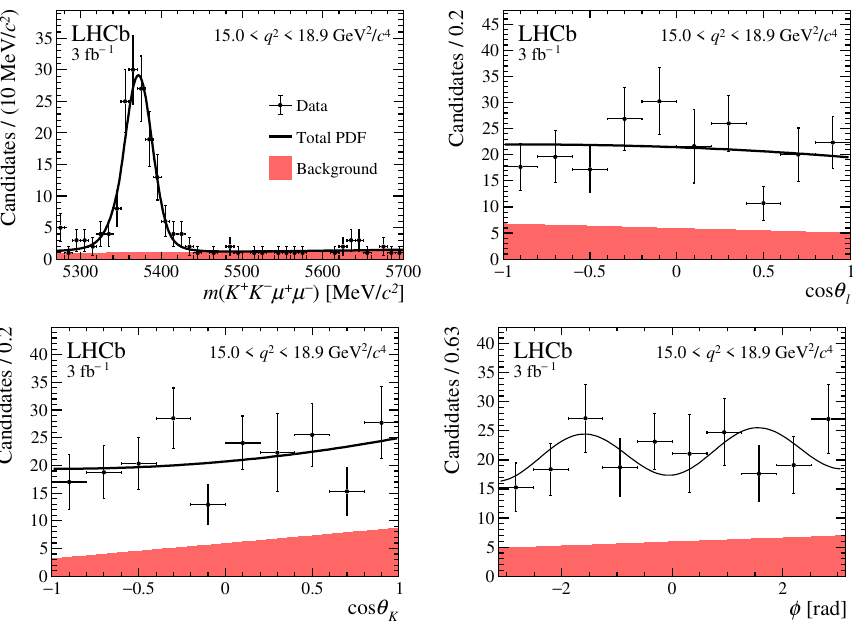
Figure 30 . Mass and angular distributions of B 0 15 . 0 < q 2 < 18 . 9 GeV 2 /c 4 for data taken in 2011–2012. The data are overlaid with the projec- tions of the fitted PDF.